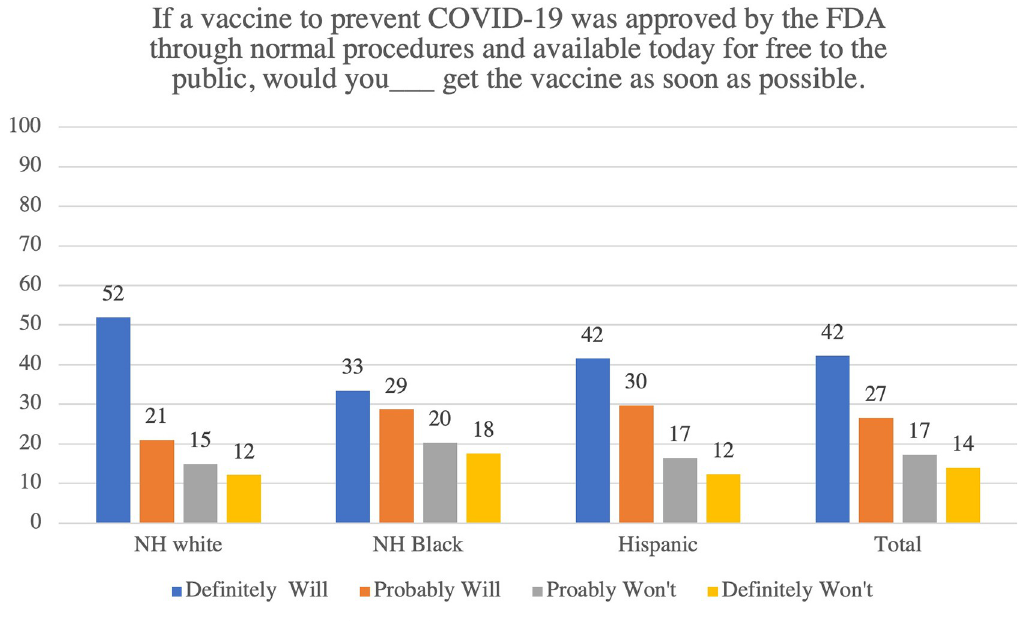
Fig 1. COVID-19 vaccination intentions by